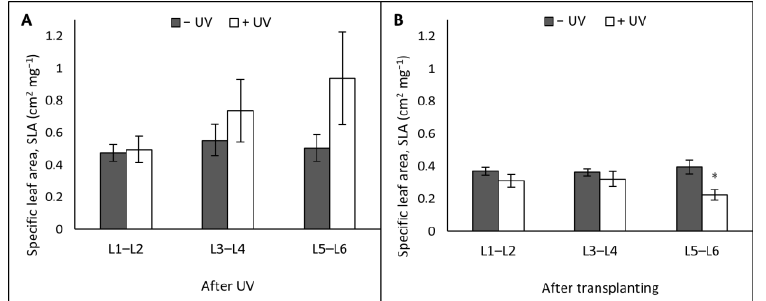
Figure 7. The parameter measured was the leaf dry weight (LDW, mg) across leaf L1 – L2, L3 – L4, and L5 – L6 after the UV ( A ) or after transplanting ( B ) . Before the UV exposure stage, the mean of the LDW for L1 – L2 was 0.876 mg, for L3 – L4 was 0.708 mg and for L5 – L6 was 0.170 mg. Asterisks indi- cate a significant difference between the UV treatments with p ≤ 0.001 (**).